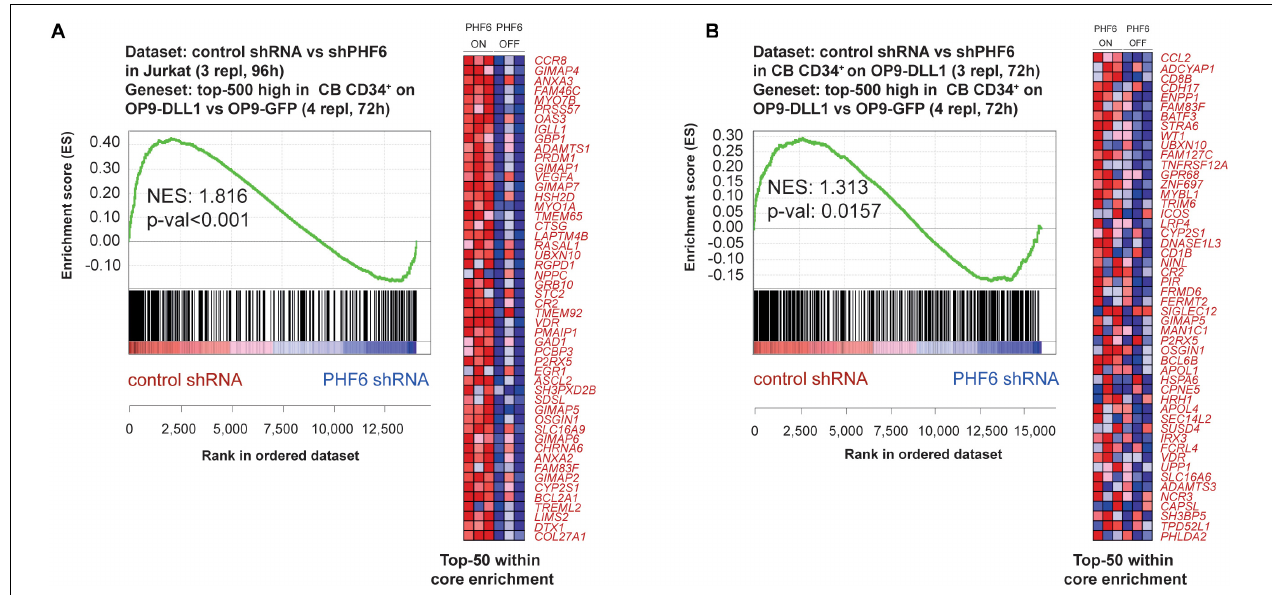
FIGURE 5 | PHF6 modulates the Notch1 gene signature. Gene Set Enrichment Analysis shows that the top-500 significantly induced genes in CB CD34 + progenitors cultured on an OP9-DLL1 stromal feeder layer in comparison to OP9-GFP cocultures are significantly enriched in the set of genes that are downregulated upon stable knockdown of PHF6 in panel (A) Jurkat T-ALL cells (GSE85373) and (B) CB CD34 + cells cultured on an OP9-DLL1 stromal feeder layer